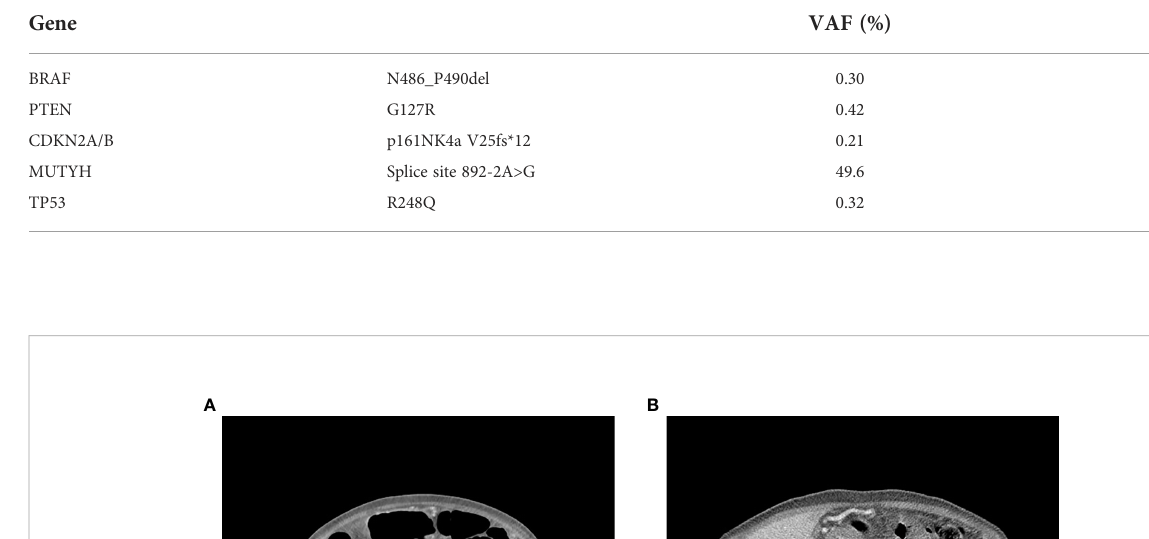
TABLE 1 Genomic fi ndings of next-generation sequencing (FoundationOne Liquid